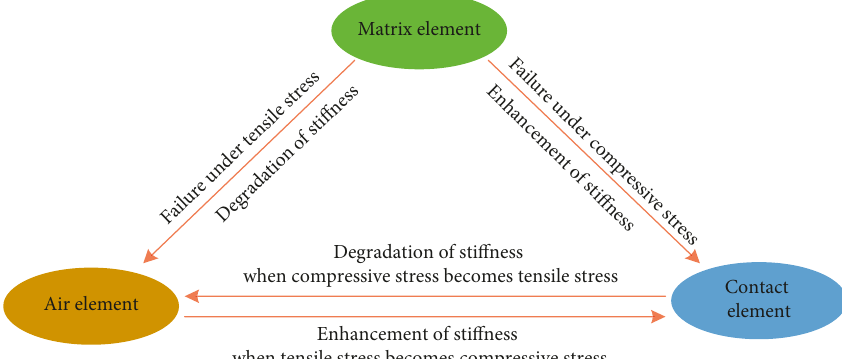
Figure 5: The types of elements and their transformation process.